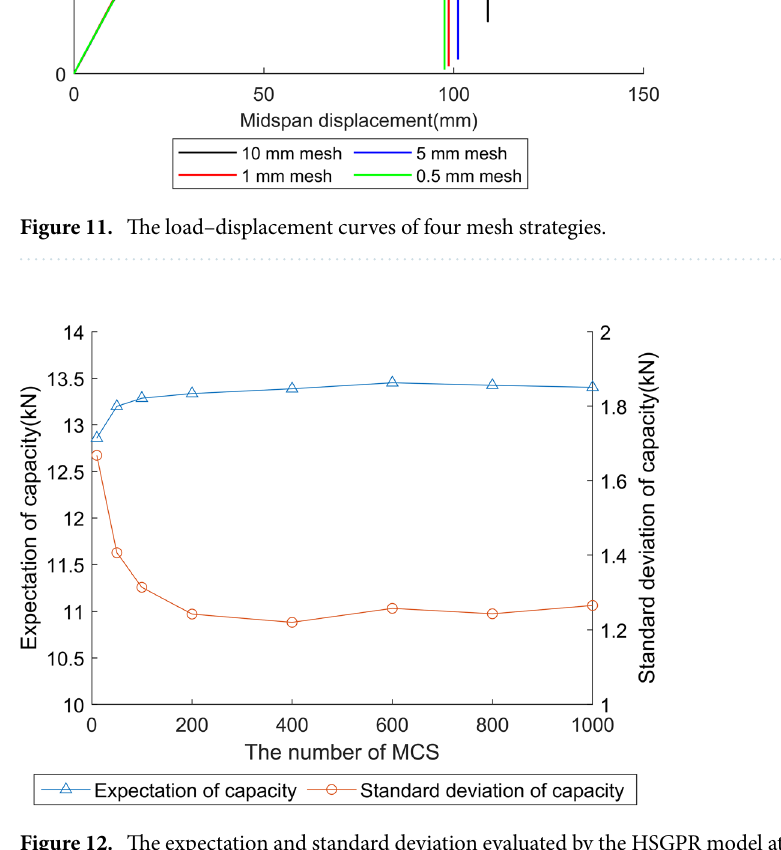
Figure 12. The expectation and standard deviation evaluated by the HSGPR model at the different number of MCS. (Temperature = 175 °C, COV = 0.10, the number of data curves =